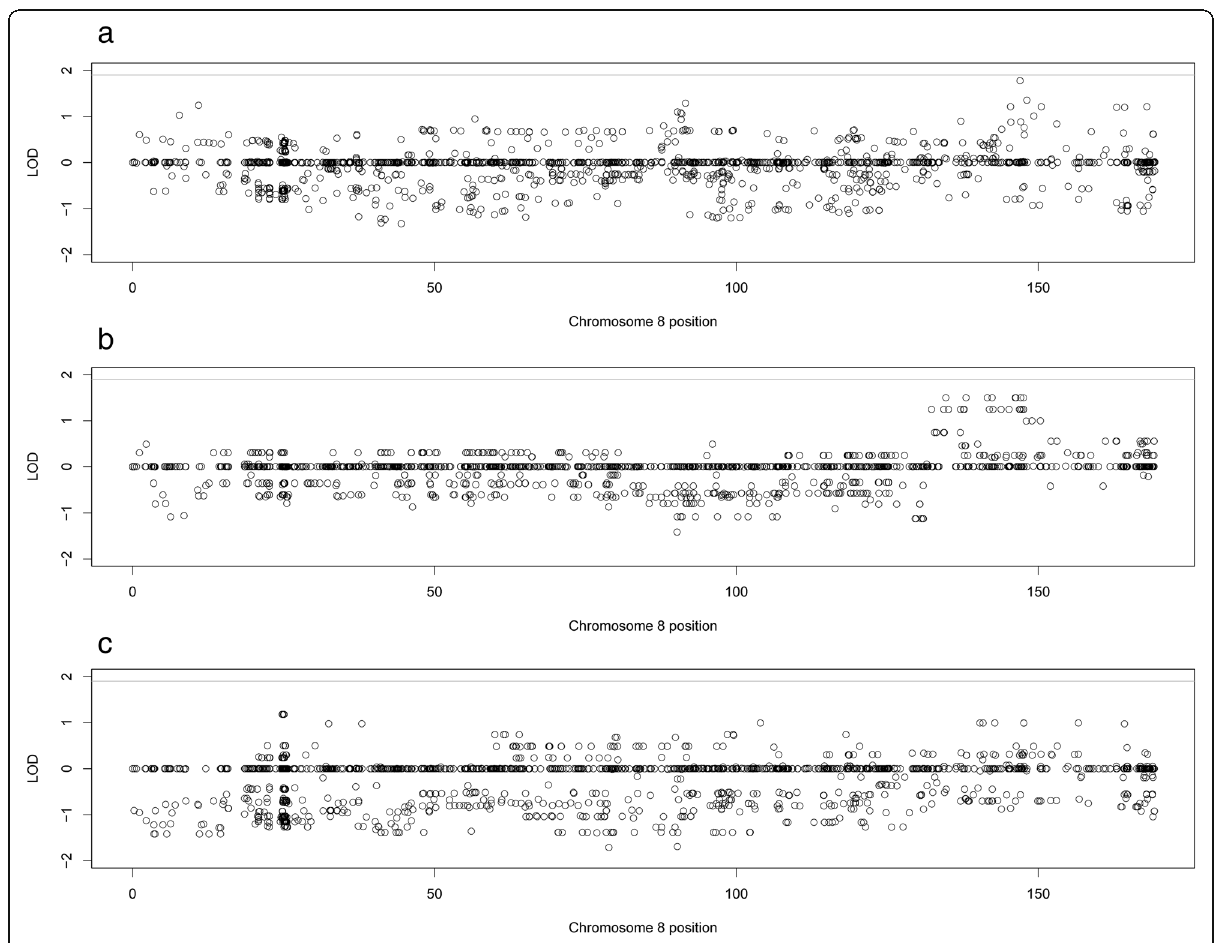
Fig. 6 Plots of two-point LOD scores for across chromosome 8 (in cM) produced by TwoPointLods for the three strongest linked families. a . Plot of family 1019. b . Plot of family 1057. c . Plot of family 1068. In all three plots, the genome-wide significant nonsynonymous exonic variant located in WISP1 is shown in blue and the line at 1.9 represents the suggestive threshold recommended by Lander and